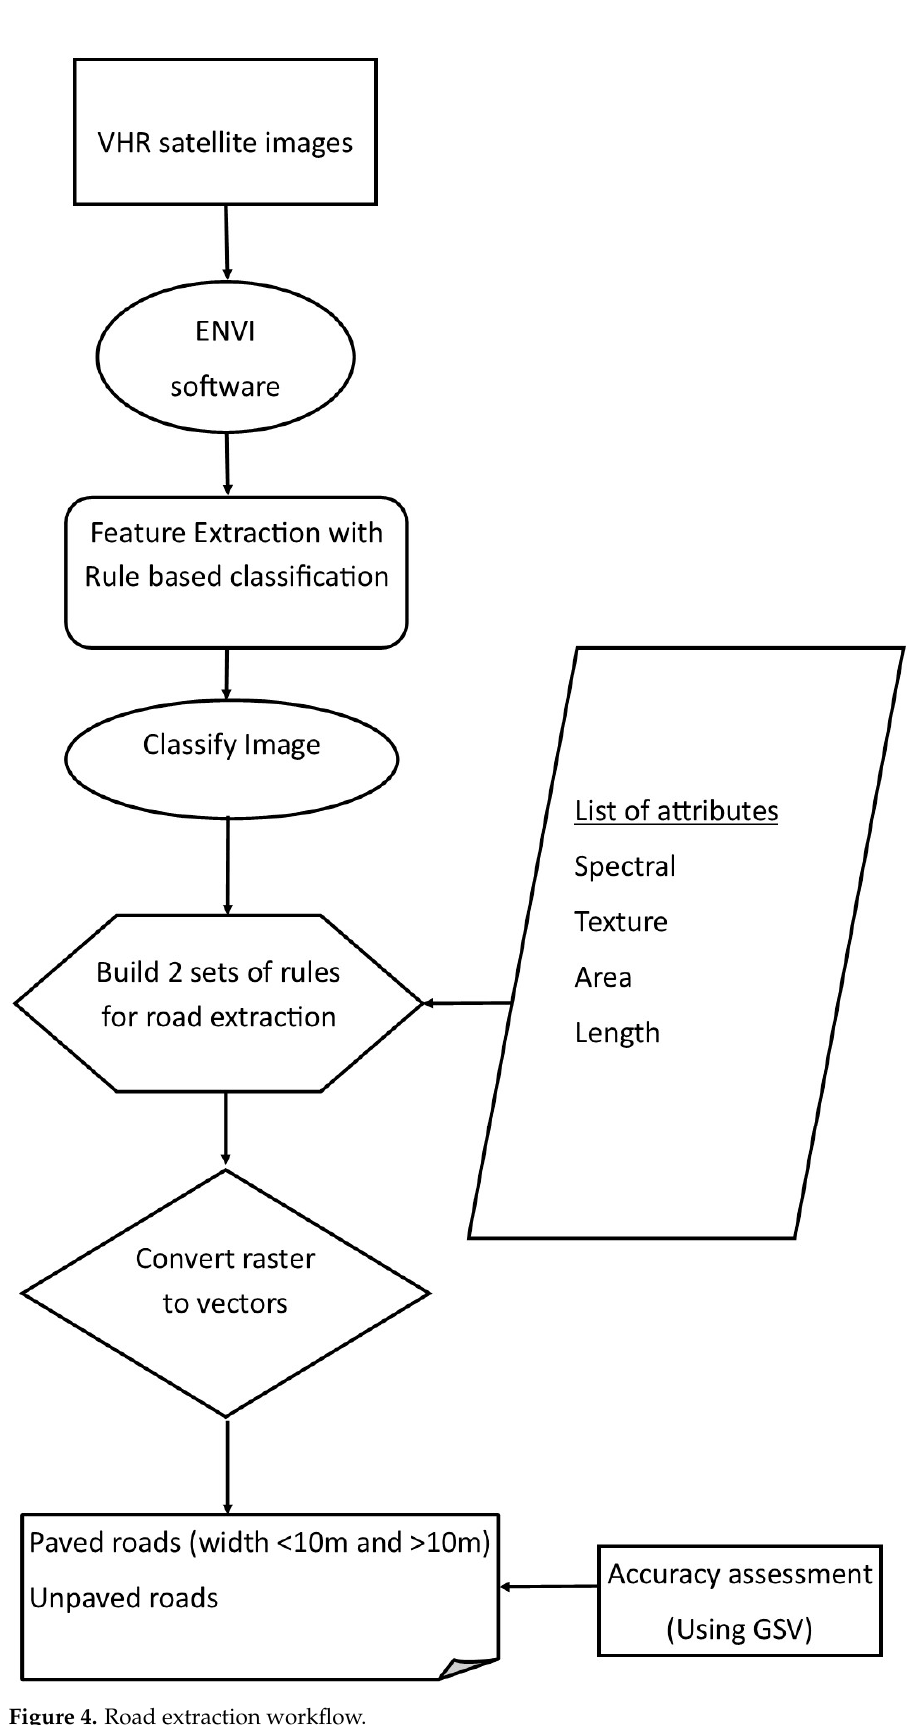
Figure 4. Road extraction workflow.